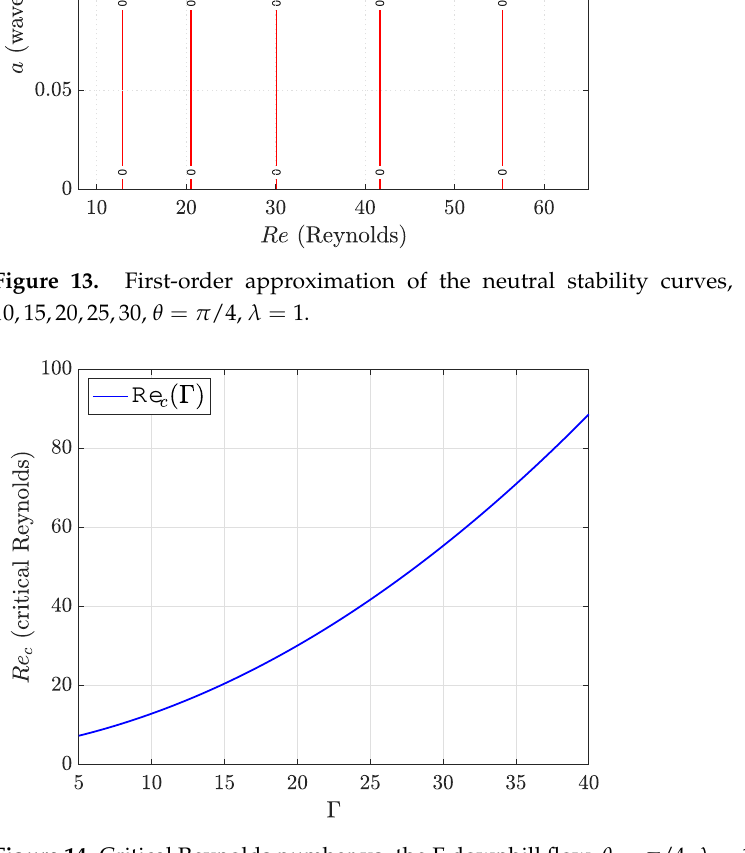
Figure 14. Critical Reynolds number vs. the Γ downhill flow. θ = π /4, λ =